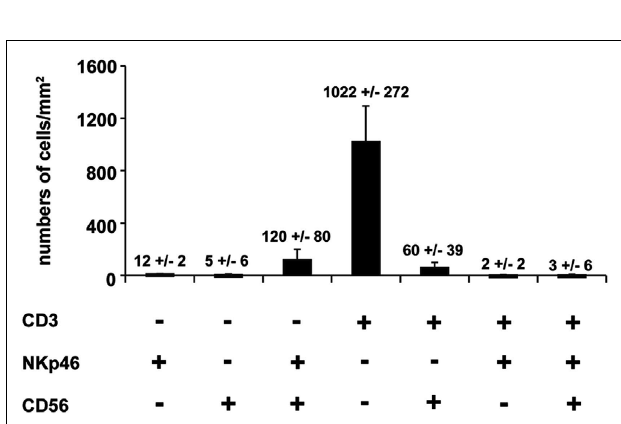
FIGURE 2 | Staining with anti-NKp46, anti-CD56, and anti-CD3 in human spleen and gut. (A,B) Frozen sections of human spleen (A) or colon (B) were stained with polyclonal anti-NKp46 serum (green), anti-CD56 mAb (red), and